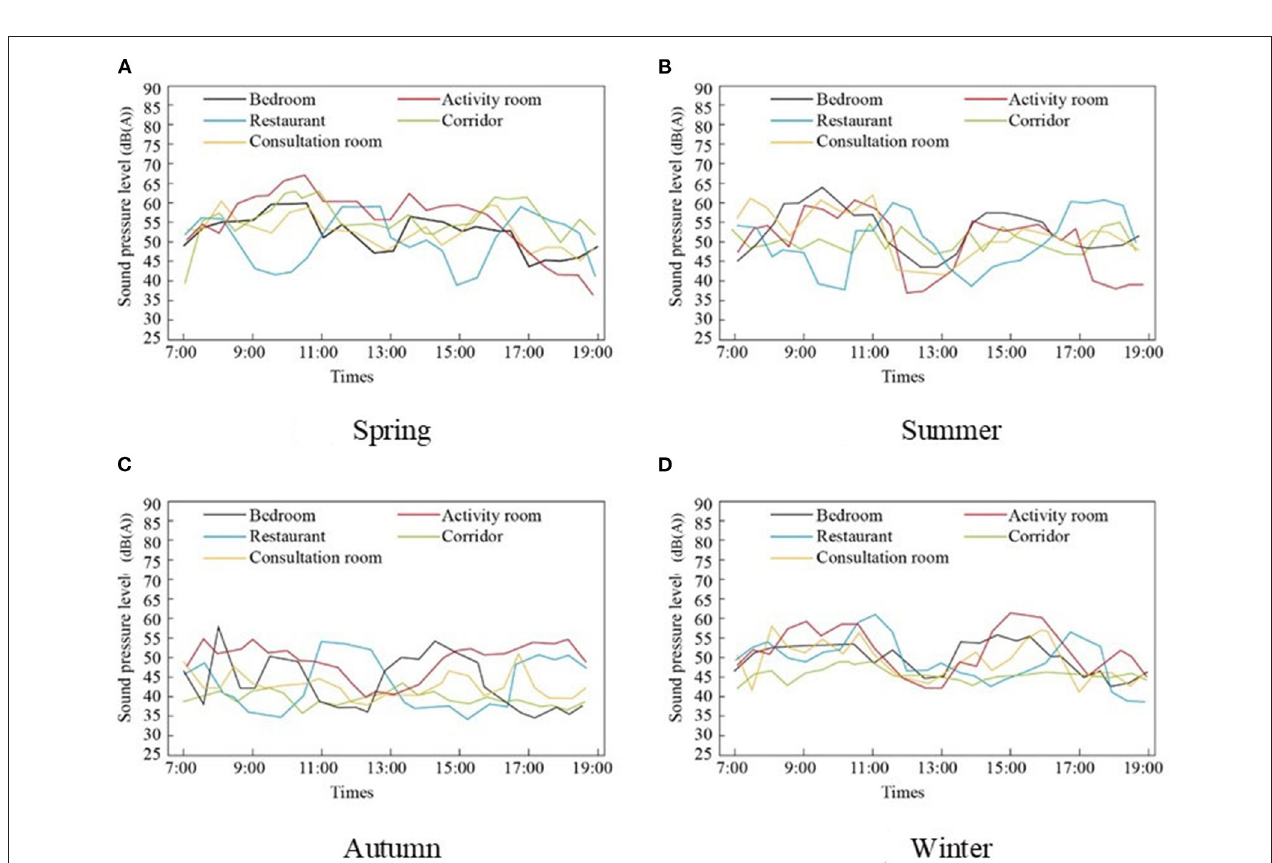
FIGURE 2 | SPL measurement in different seasons and different rooms. (A) Spring, (B) Summer, (C) Autumn, and (D) Winter.